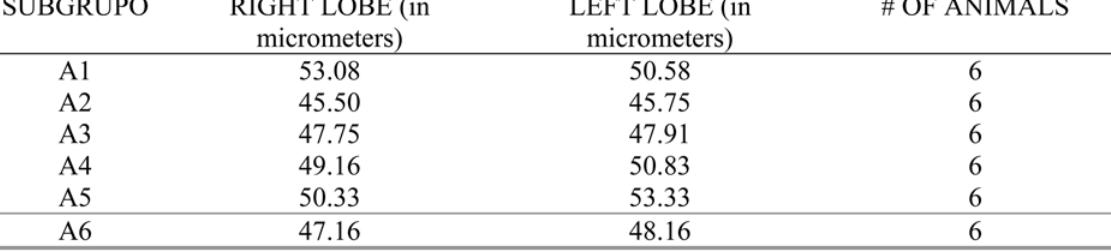
TABLE 5 - Number and cause of death of animals in the control group.